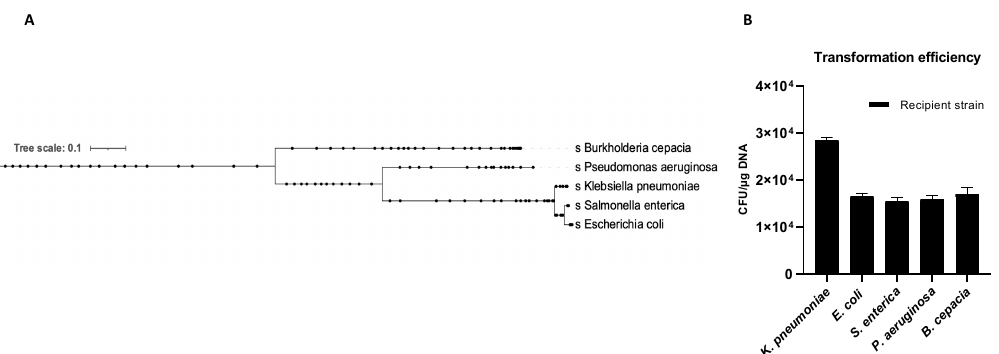
Figure 6. Phylogenetic relationship of the recipient species ( A ). K. pneumoniae -pGR OMVs inter-species transformation efficiency ( B ).